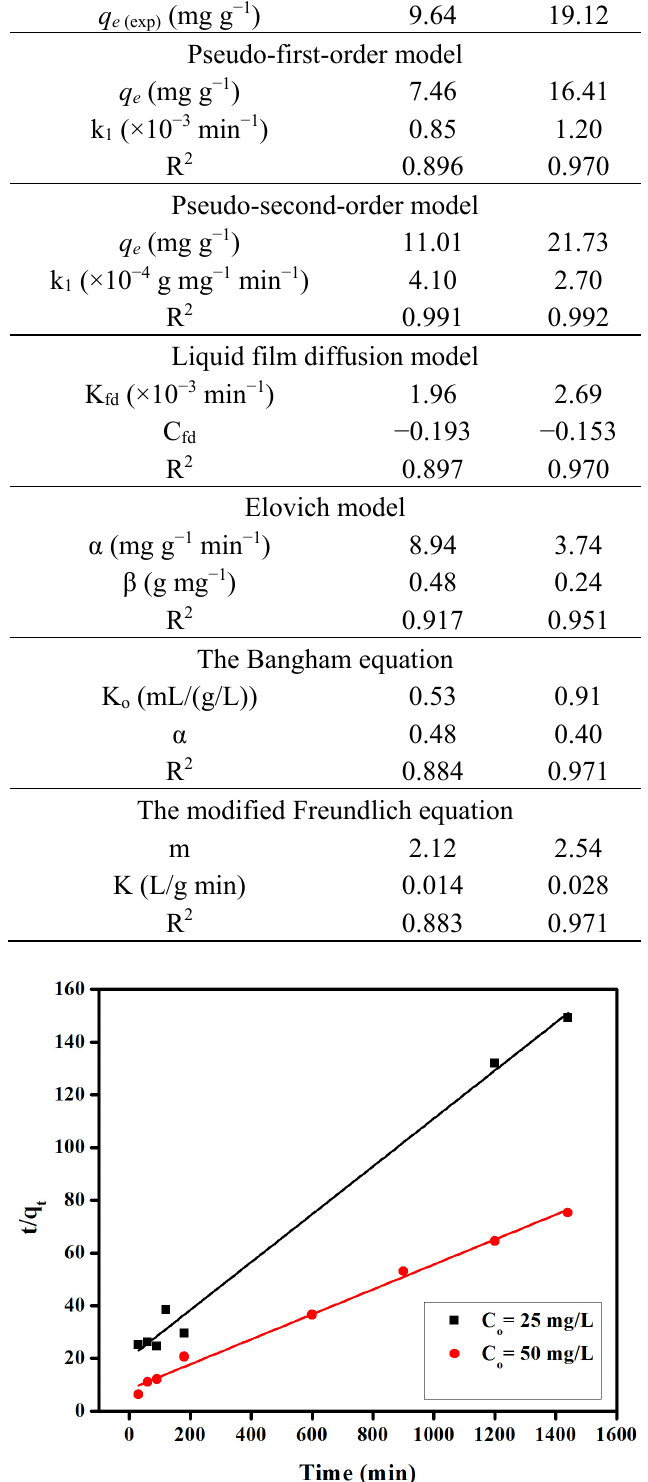
Figure 7. Pseudo-second-order Kinetics for adsorption of congo red on anion exchange membrane